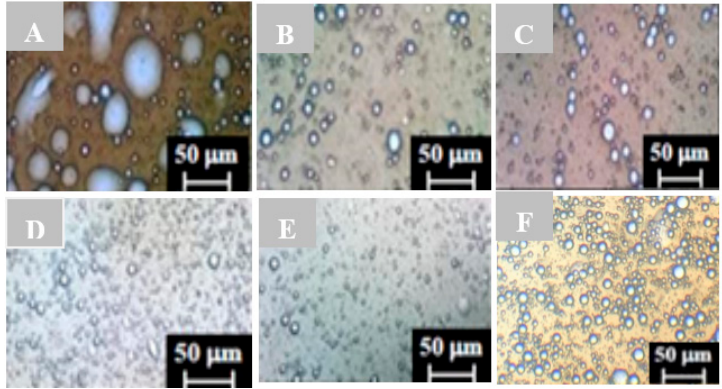
Figure 2. Comparison with the microstructural characteristics of the emulsions droplets formed from bioemulsifier produced by C. lipolytica UCP 0988, Assay 4 of the factorial design 2 2 (5% ( v / v ) corn steep liquor and 8% ( v / v ) waste soybean oil) using light microscopy: ( A ) liquid without inoculum; ( B ) culture at 24 h; ( C ) culture at 48 h; ( D ) culture at 72 h; ( E ) culture at 96 h; and ( F ) Control (Sodium dodecyl sulfate-SDS).